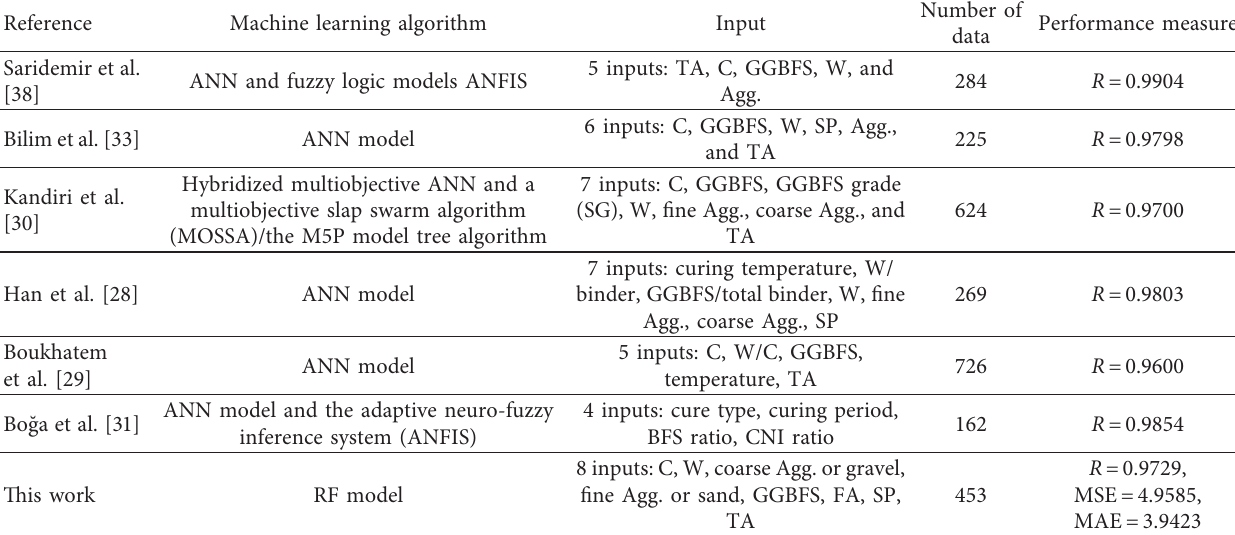
Table 4: Comparison of different machine learning models for predicting compressive strength of concrete.